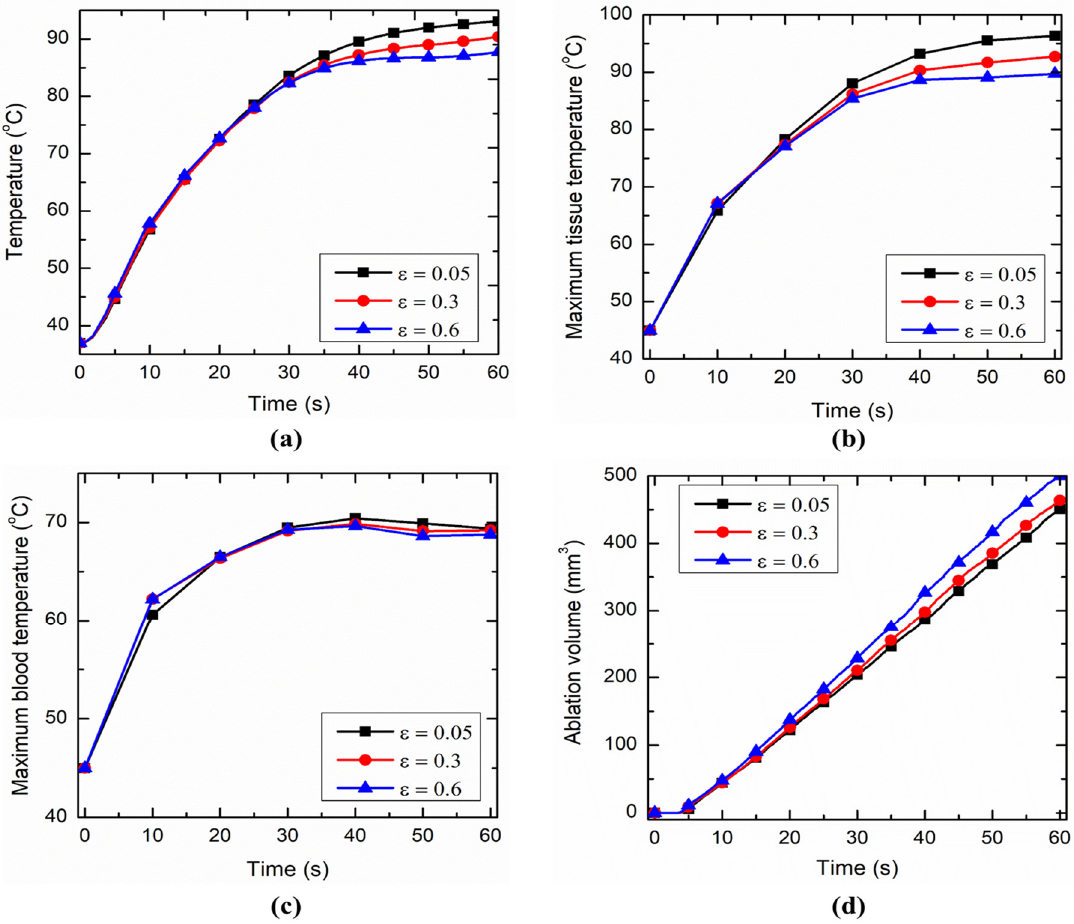
Figure 3. Temporal variation of: ( a ) temperature at a point 1 mm away from tip of electrode, ( b ) maximum tissue temperature, ( c ) maximum blood temperature, and ( d ) ablation volume for different values of porosity.